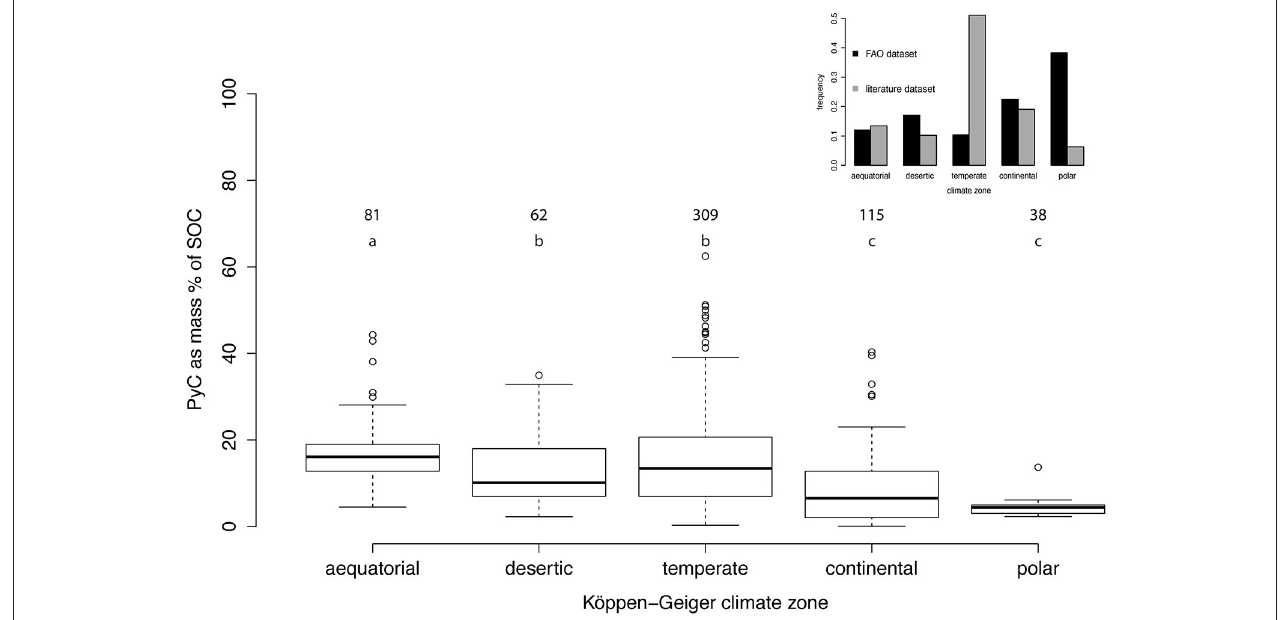
FIGURE 7 | PyC content as mass % of the total SOC as a function of the climatic zone. Only the five KG supergroups were used. Equatorial relates to all groups starting with a A in the KG classification, desertic with a B, temperate with a C, continental with a D and polar with a E. The One-Way-ANOVA resulted in a p < 0.001. The different letters on the top indicate the significant differences ( p < 0.05) between the different KG